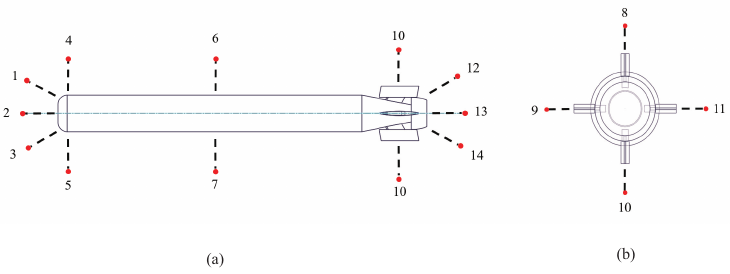
Figure 2. Monitoring point location diagram. ( a ) Side view ( b ) Rear